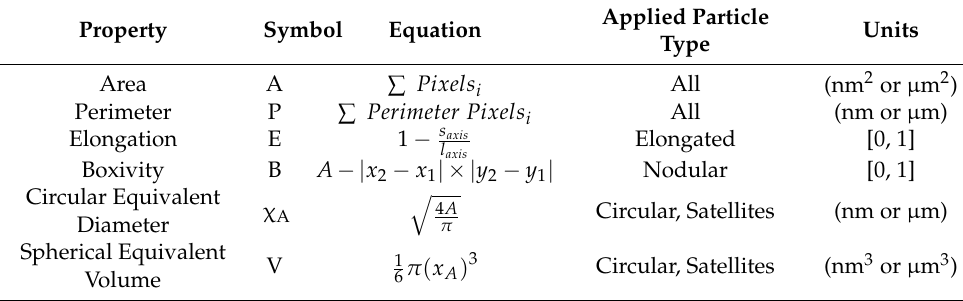
Table 5. Statistical evaluation of the results.